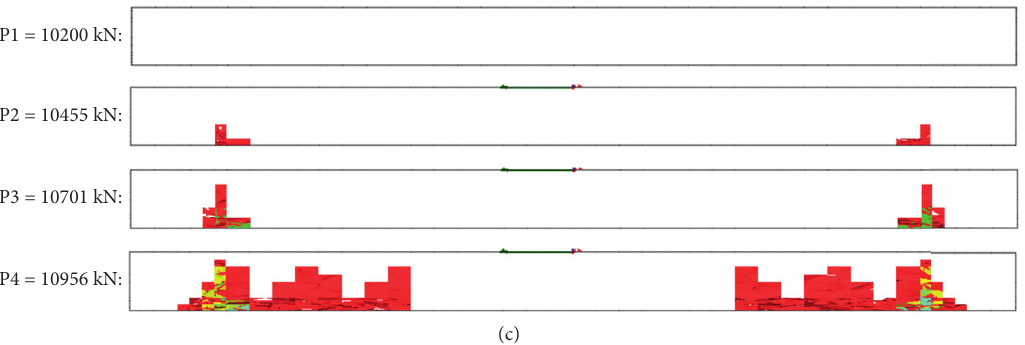
Figure 11: Longitudinal section of web crack. (a) S-web. (b) SS-web. (c) M-web.